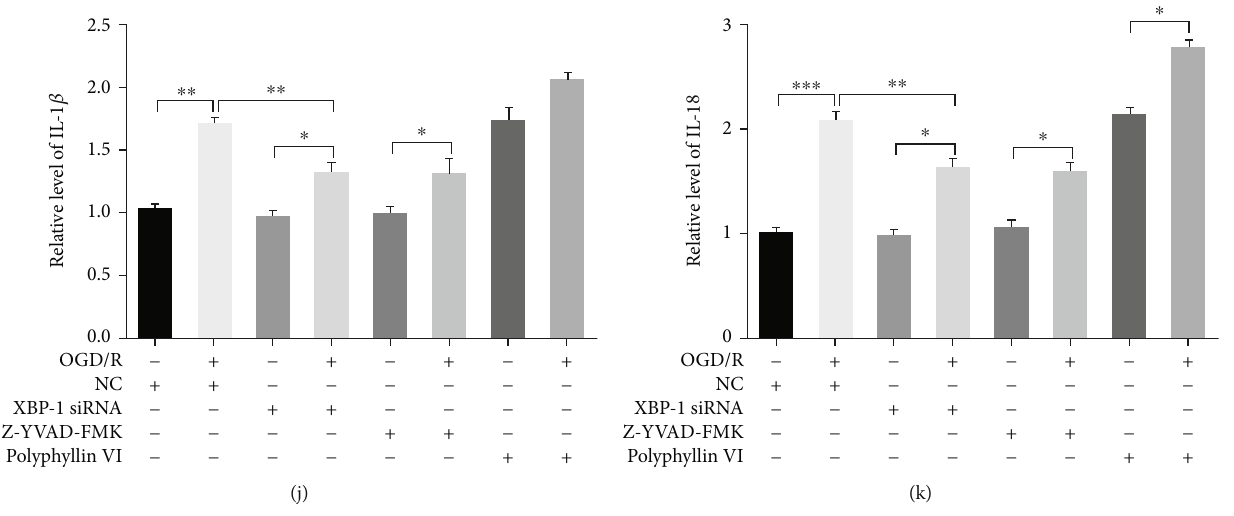
Figure 4: Downregulated XBP-1 restored the cell viability and inhibited cytotoxicity and pyroptosis by OGD/R in HT22 cells. The HT22 cells were, respectively, pretreated with XBP-1 siRNA, 24h before exposing to OGD/R for 24h and Z-YVAD-FMK (20 μ M) and polyphyllin VI (4 μ M) 30 min before exposing to OGD/R for 24 h. (a) Cell viability was detected in HT22 cells by using CCK-8 assay. (b) LDH release was detected in HT22 cells by using LDH assay. (c) The quantity of necrotic cells and pyroptotic cells were analyzed by Annexin V and PI staining in each group. (d) The ratio of pyroptosis was represented the percentage of Annv + /PI + cell population. (e) Representative western blots and quanti fi cation of indicated proteins in the cellular lysate from HT22 cells in each group. Relative expression was normalized to control group. (f – k) The expression levels of XBP-1s, NLRP3, Caspase-1, GSDMD-N, IL-1 β , and IL-18 in HT22 cells after OGD/R. Asterisks indicate statistical signi fi cance ( ∗ p < 0 : 05 , ∗∗ p < 0 : 01 , ∗∗∗ p < 0 : 001 ). All experiments were repeated for three